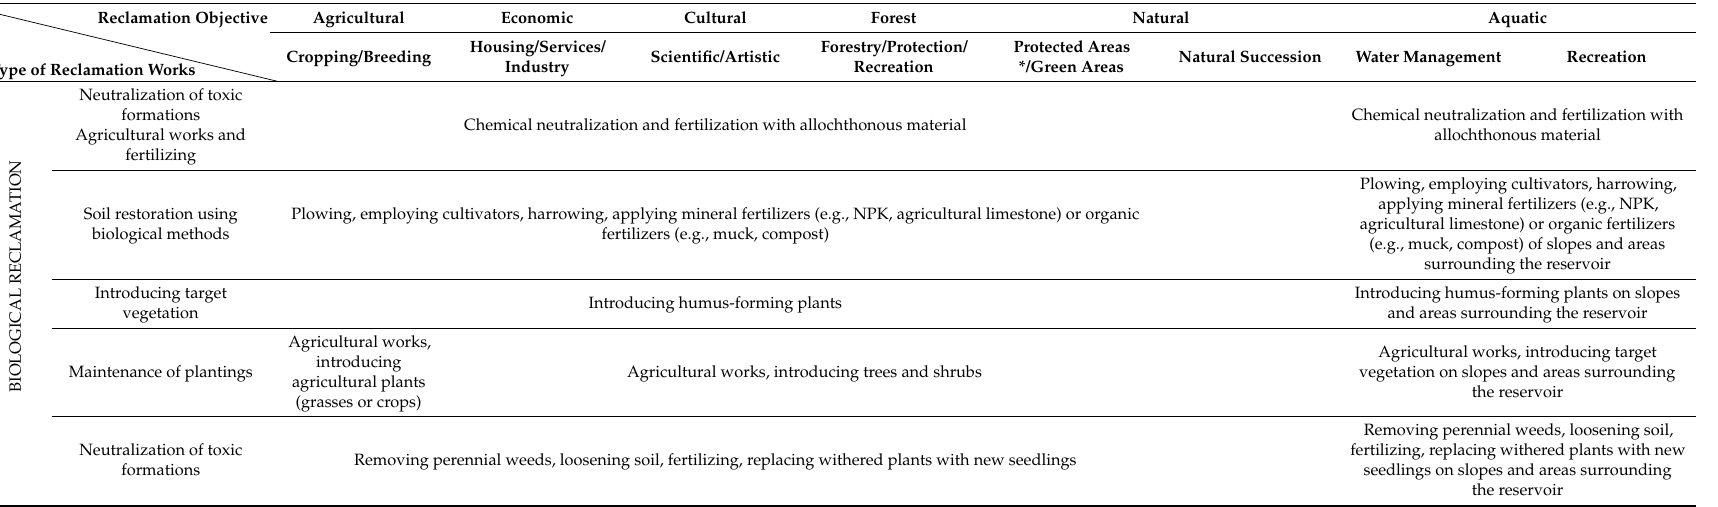
Table 5. The scope of reclamation works of the biological phase for areas after exploitation of compact